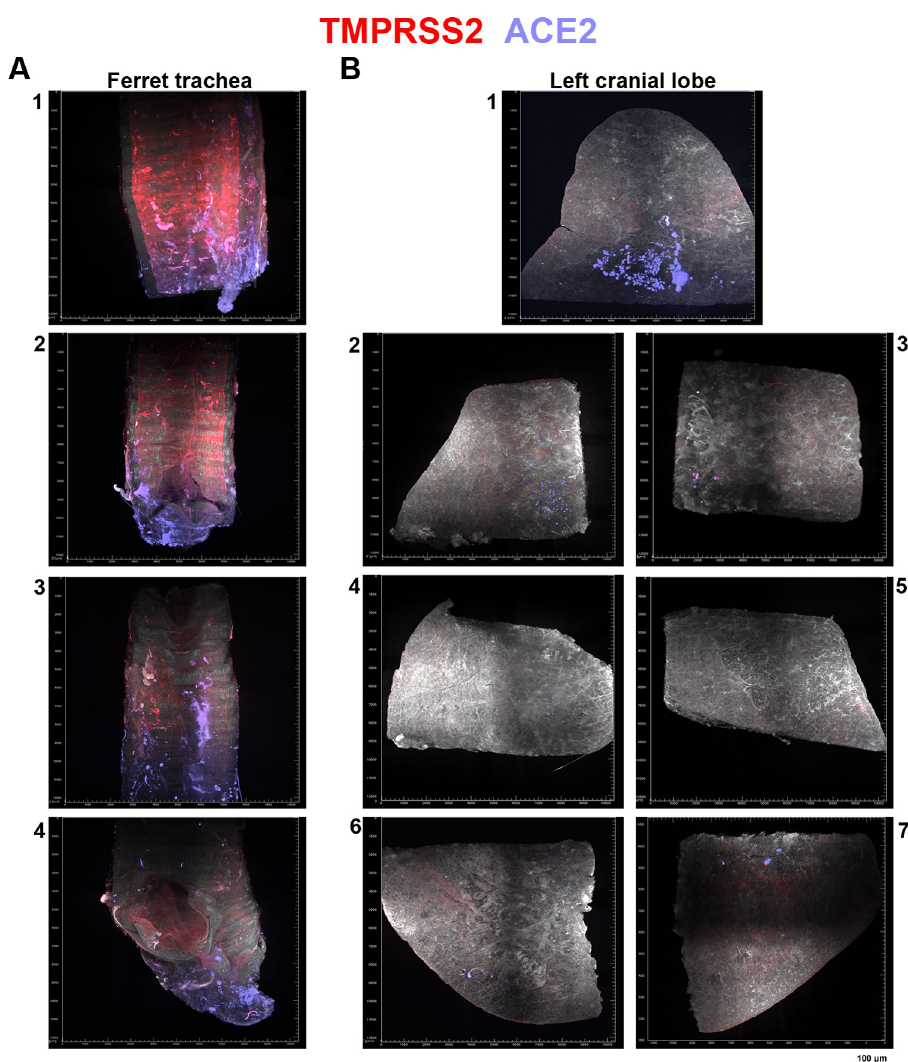
Fig 7. ACE2 and TMPRSS2 expression in the ferret animal model. TMPRSS2 fluorescence signal in red and ACE2 signal in purple. (A) In the ferret trachea, TMPRSS2 expression is observed with occasional ACE2 signal. Ferret trachea was cut into multiple pieces due to dimensional limitations of the microscope and after imaging and analysis the ferret trachea imaging data was placed in the order the ferret trachea was cut in, with panels 1–4 comprosing these cut trachea parts. Panel 1, part of the trachea that attaches to the ferret head with panel 4 being the part that is attached to the left cranial lobe. Panel 2 and 3 are parts of the trachea that are attached to the parts in panel 1 and 4. (B) In the left cranial lobe, minimal ACE2 expression is observed with no apparent TMPRSS2 signal. The left cranial lobe was cut into seven pieces, shown in panel 1–7. With panel 1 being the upper portion and panel 6/7 being the lower portion of the lobe, panel 2–5 are the pieces that connect panel 1 and 6/7 to form the entire cranial lung